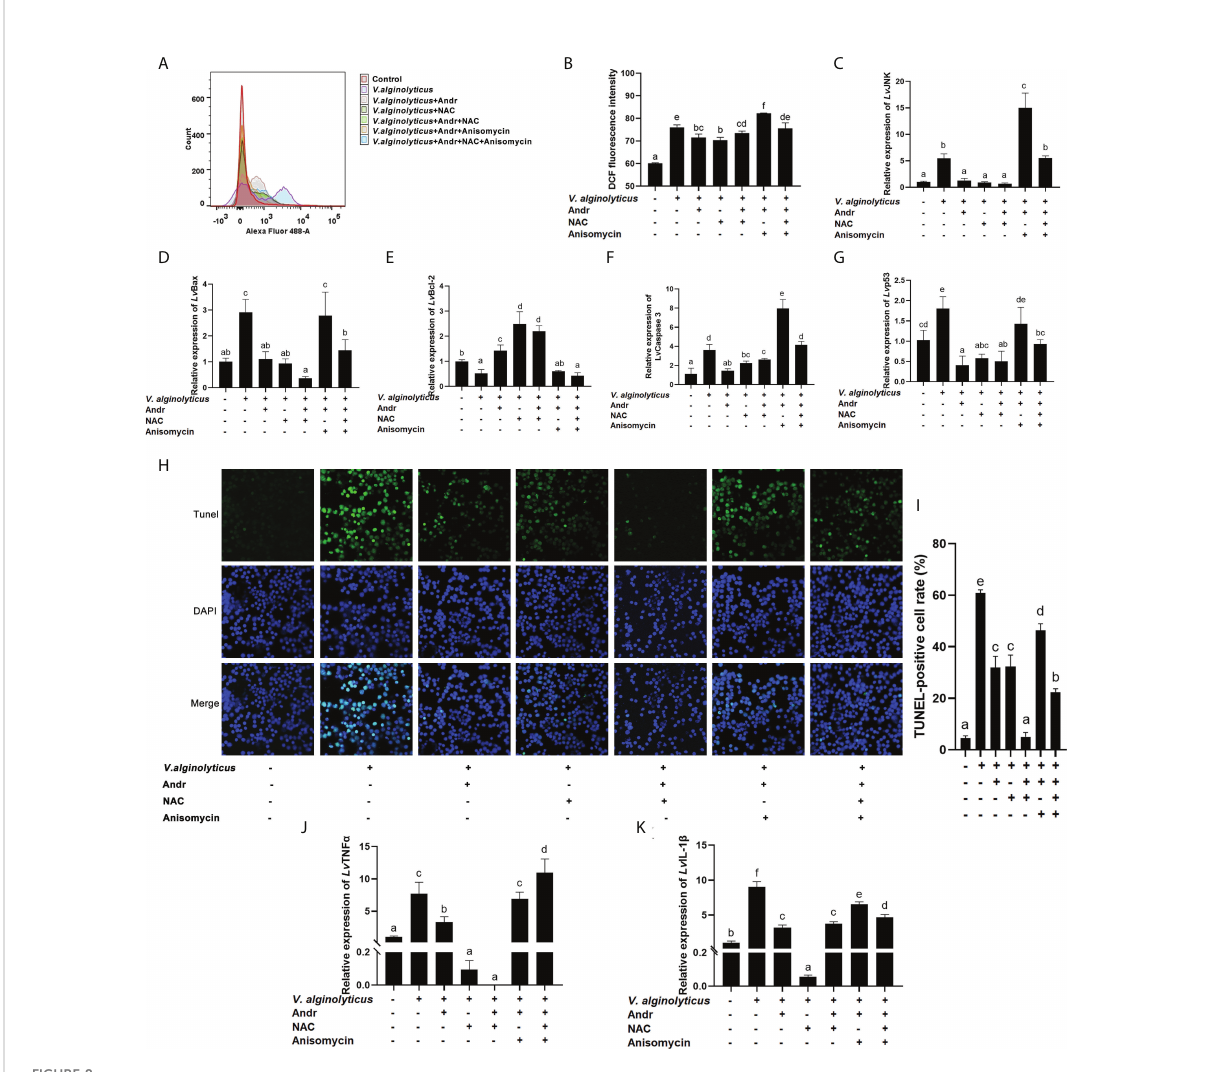
FIGURE 8 Andr reduces V. alginolyticus -induced apoptosis by inhibiting ROS generation and JNK activation. Uninfected or V. alginolyticus -infected cells were treated with Andr, NAC or anisomycin. At 24 h, the cells were detected for the related indices. (A, B) The ROS level were detected by fl ow cytometry. (C-G) The expression of JNK and apoptosis-related gene detected by qPCR. (H, I) The apoptosis detected by TUNEL stain. (J, K) The expression of TNF a and IL-1 b detected by qPCR. Values are means ± SD. a,b,c,d,e,f Value bars not sharing the same superscript letter are signi fi cantly different as evaluated by Duncan ‘ s test ( p <